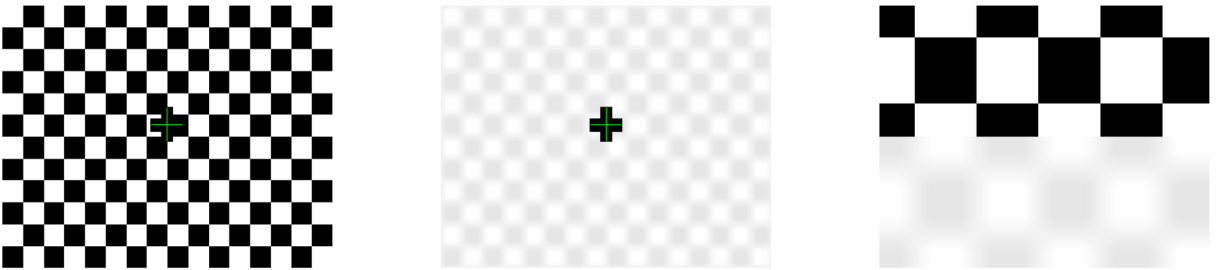
Figure 3. Example sequence. Left: cropped middle section, around the crosshair, of a bias image. Middle: the corresponding section of a trigger image. Right: a more detailed comparison, illustrating convolution of the trigger image ( n = 13).